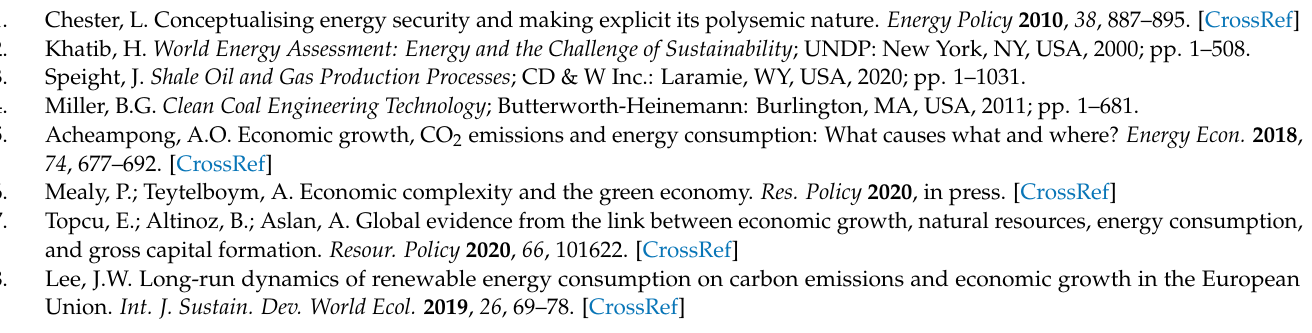
Figure A6. Variance decompositions in model 3 using Cholesky factors.